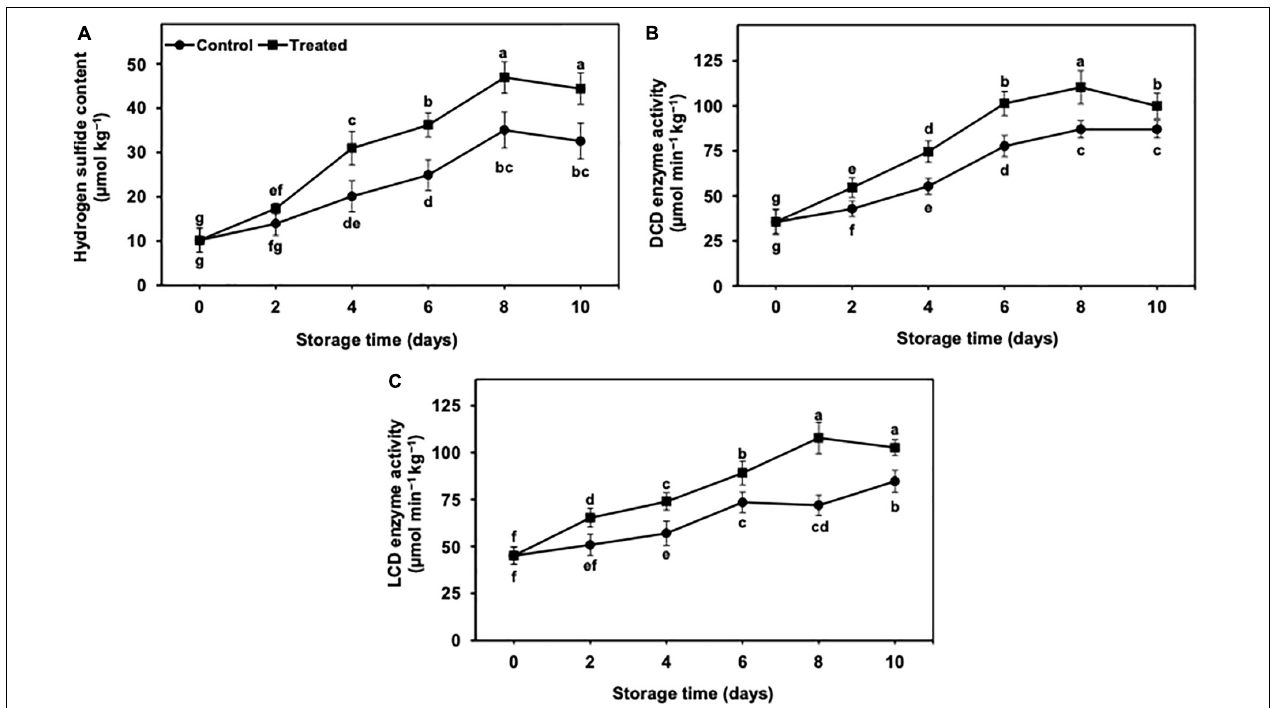
FIGURE 3 | Effect of hydrogen sulfide on endogenous hydrogen sulfide content (A) , DCD (B) and LCD (C) enzymes activity in peel of banana fruit. Data are mean of three replications and vertical bars show standard of the means. Different letters show significant difference according to least significant difference test.